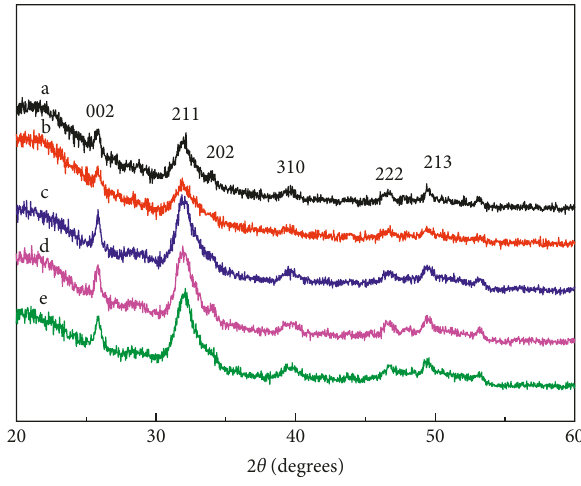
Figure 2: XRD patterns of HAP particles obtained by using IDACS as an organic matrix with different molar ratios of chitosan